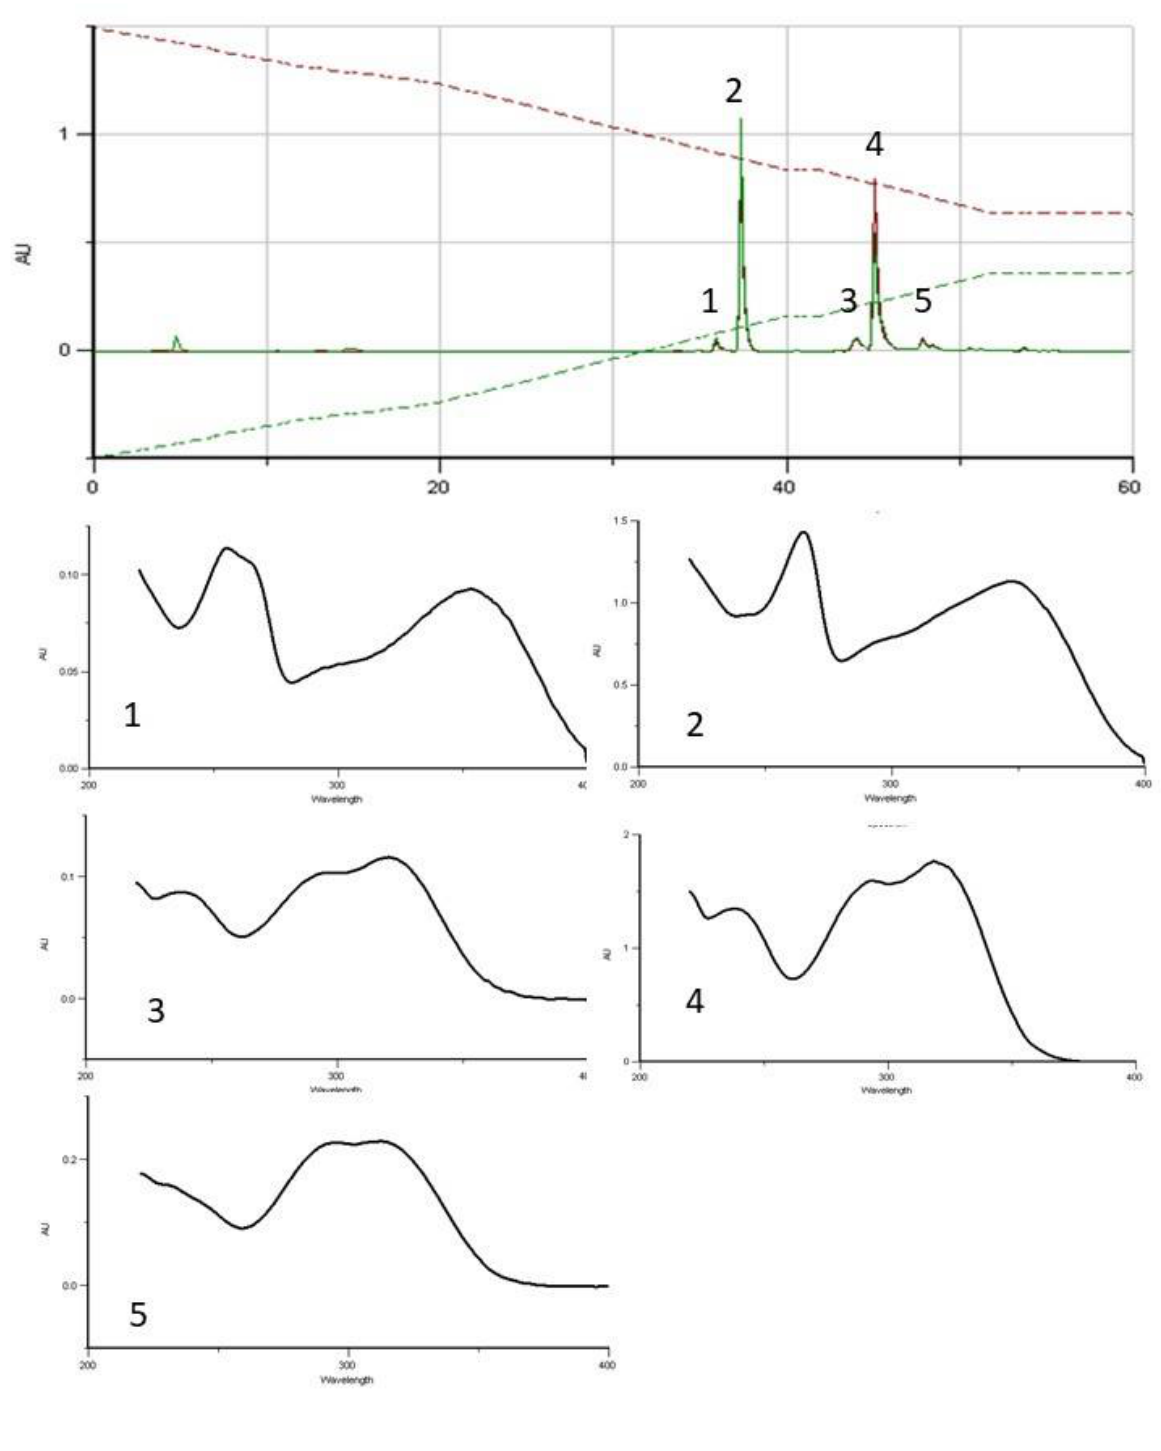
Figure 2. Phenolic/Flavonoidic profile of the two samples. ( a ) E. globulus ; ( b ) S. atrocinerea obtained with HPLC/DAD analysis and plotted at 260 and 340 nm; Right side of the figure show the respective UV-spectra for each flavonoid and phenolic acid derivatives. ( a ) Compounds: 1. Quercetin-3- O -sophoroside; 2. myricitin; 3. tricetin; 4. luteolin; 5 and 6. derivatives of cinnamic acid-1 and 2 (spermidine); ( b ) Compounds: 1. Quercetin-3 -O -sophoroside; 2. kaempferol-3- O -neohesperidoside; 3. 4 and 5. derivatives of caffeic acid.